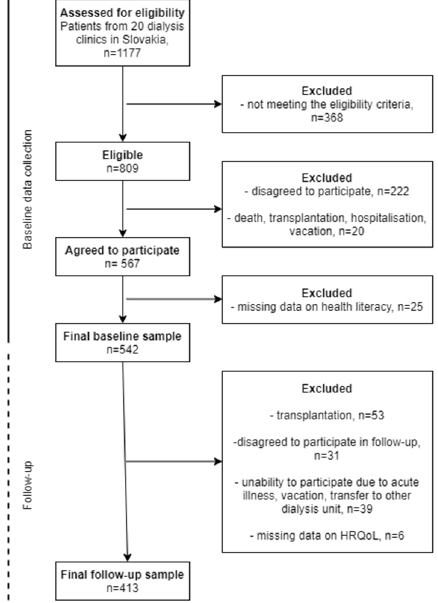
Figure 1. Flow chart of the sample. Table 1. Characteristics of the sample: gender; age; baseline clinical data; health literacy (HL); baseline health-related quality of life (HRQoL); and change in HRQoL, frequencies or means (n = 413, patients from 20 dialysis clinics in